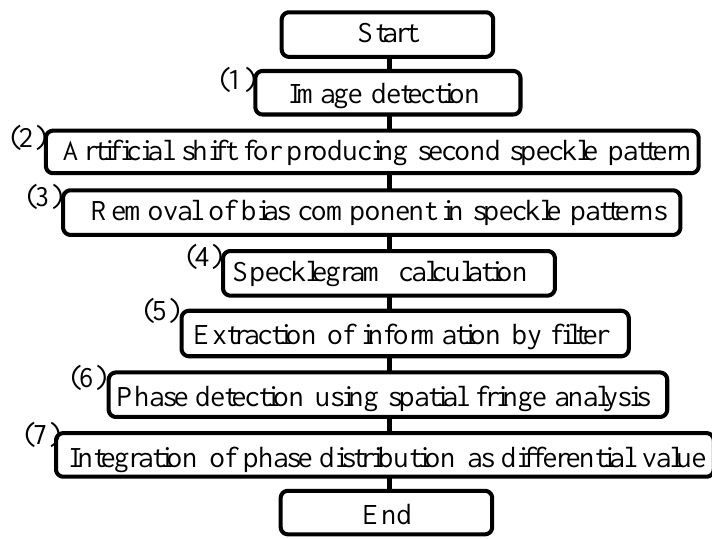
Figure 3. Flow chart of processing.